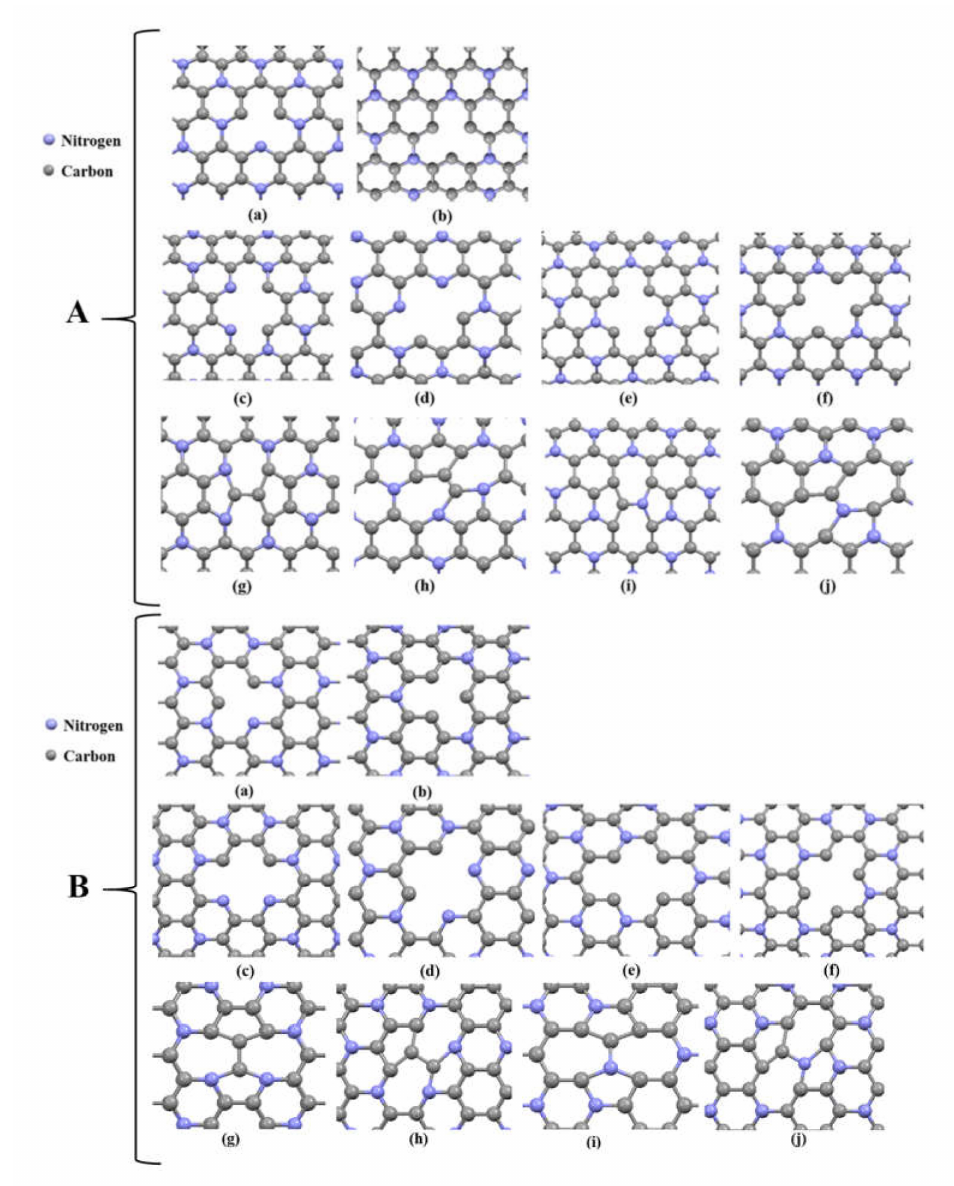
Figure 12. ( A ) Embedded defects in (10,10) armchair C 3 NNT: (a) one carbon atom vacancy, (b) one nitrogen atom vacancy, (c) and (d) two carbon atoms vacancy, (e) and (f) one-carbon and one-nitrogen vacancy, (g) and (i) Stone-wales type 1, (h) and (j) Stone-wales type 2. ( B ) Same as ( A ) but for (18,0) armchair C 3